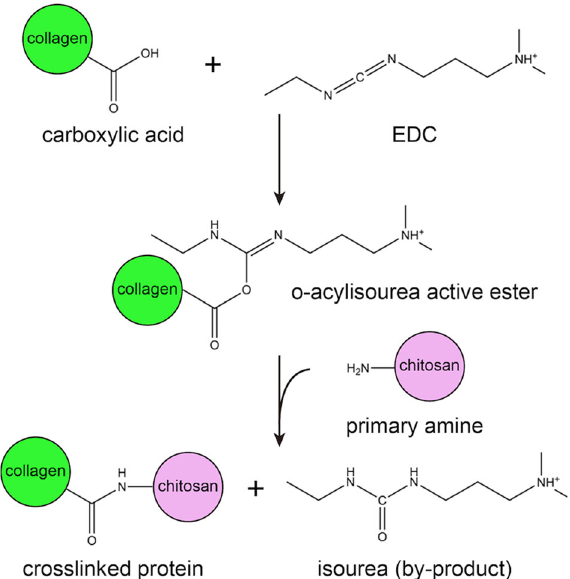
Fig. 4 EDC-crosslinked reaction scheme between human collagen type I and chitosan